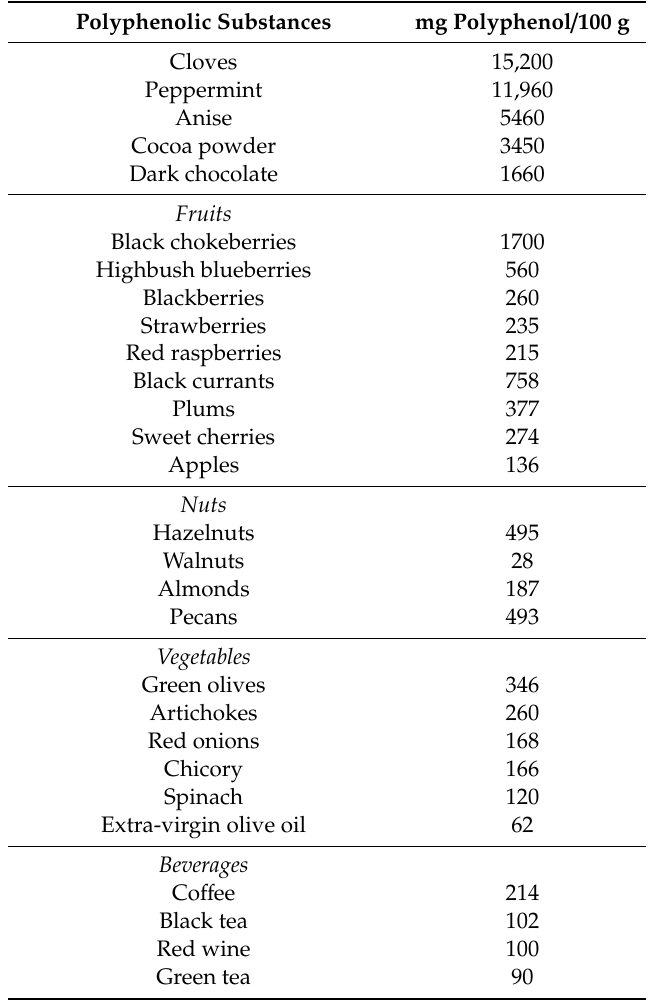
Table 2. Polyphenolic substances prevent harmful health e ff ects caused by exposure to cadmium. Polyphenols constitute one of the most common molecules present in plants, with a wide range of biological activities related to their antioxidant actions. These compounds have at least one aromatic ring with one or more active hydroxyl groups. This table provides some relevant substances and their polyphenol contents (mg / 100 g or mg / 100 mL) are reported. mg Polyphenol / 100 g Cloves 15,200 11,960 Anise 5460 3450 1660